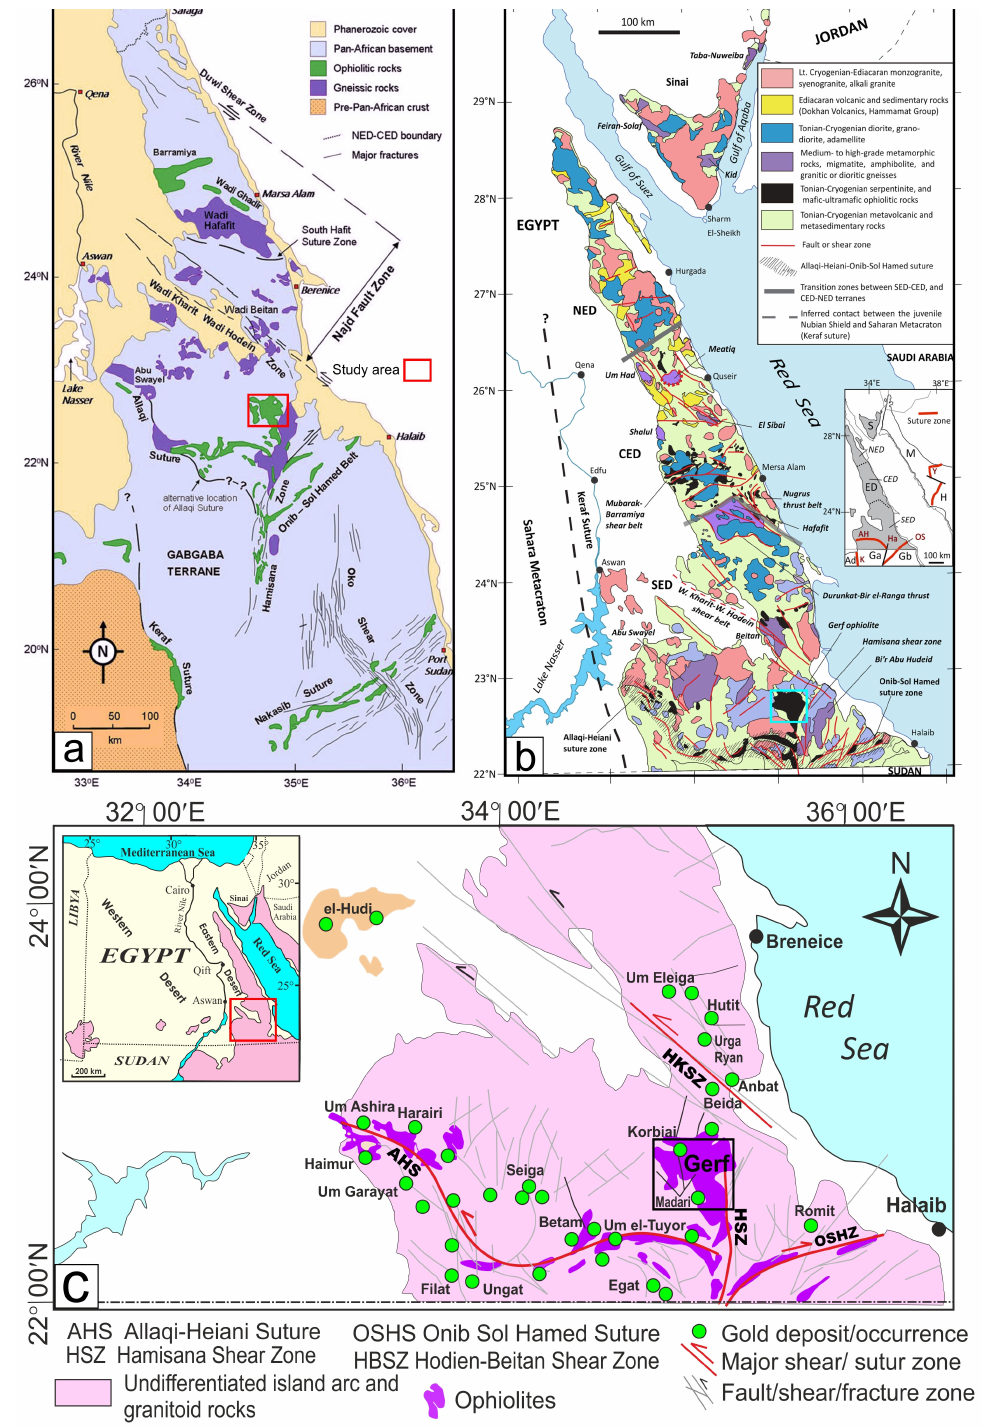
Figure 1. ( a ) The Nubian Shield of northern Sudan and Egypt modified from [9]. The locations of the Gerf ophiolite complex, N–S Hamisana Zone, and Oko Shear Zone are shown. Also shown are the major suture zones, the Allaqi–Heiani, Onib–Sol Hamed, Naskasib and Keraf suture zone of [9]. The extent of the Najd Fault Zone in the CED and SED is also shown, Inset shows a location map of the study area ( b ) Simplified geologic map of the Eastern Desert, Egypt, ( c ) Distribution of the known gold mining sites and gold quartz vein occurrences relative to the major fault/shear structures and ophiolitic masses in the South Eastern Desert terrane modified after [13]. The inset is the map of Egypt showing the location of ( c ).